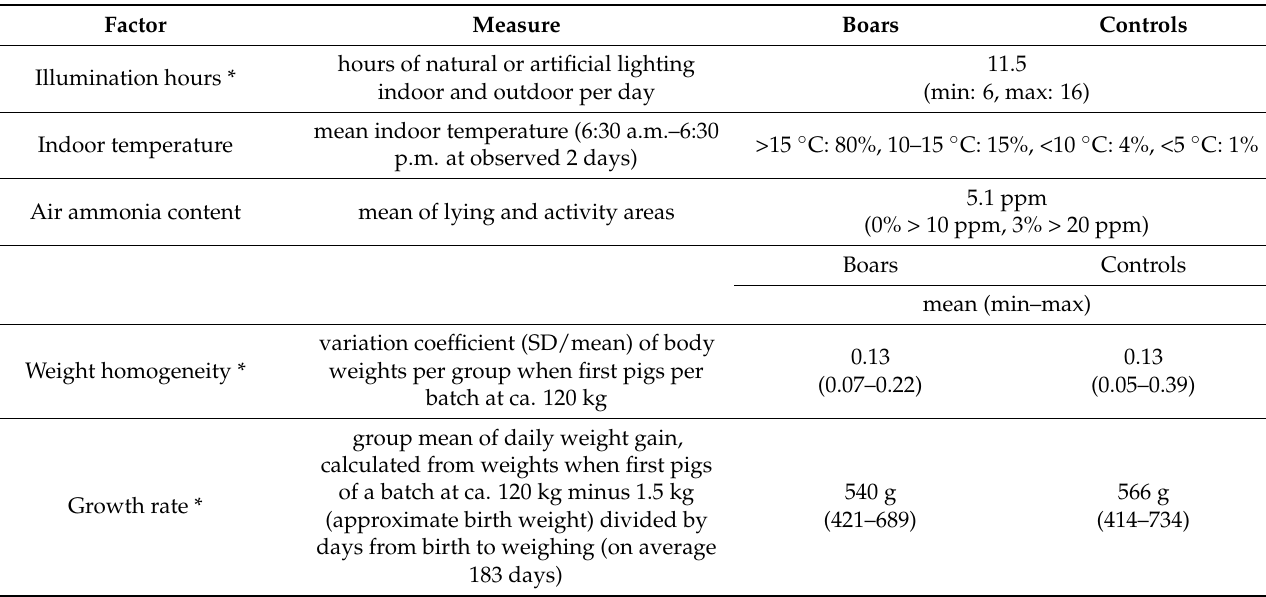
Table 5. Environmental conditions at the days of observation and body weight measures.